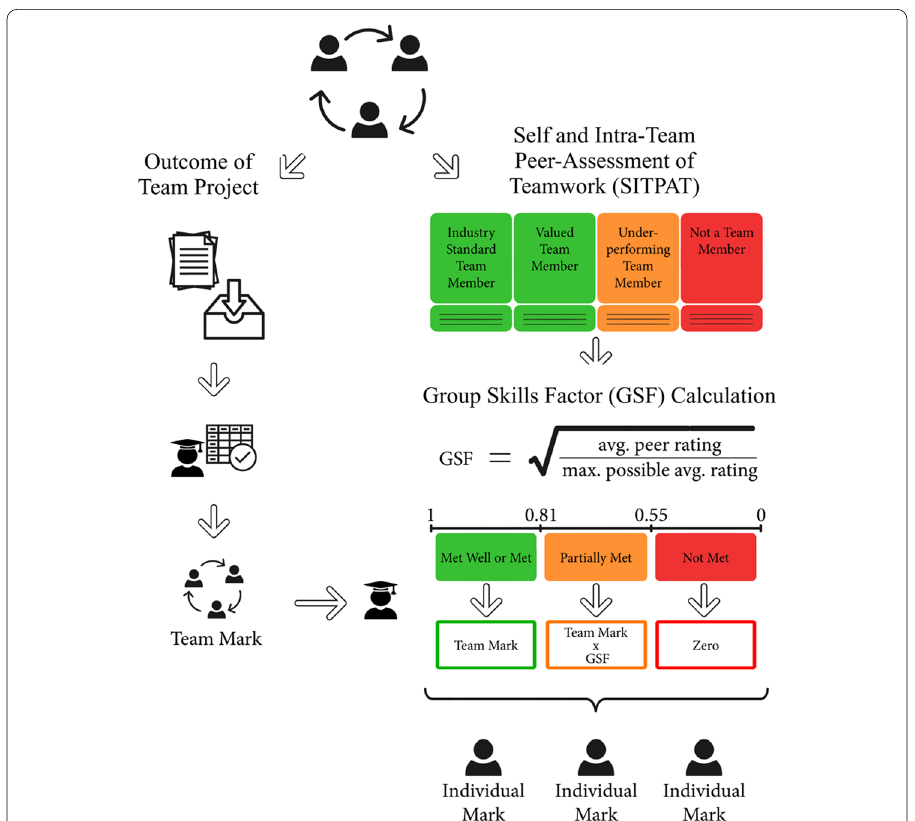
Fig. 1 The pedagogical model of the strategy illustrates the two components: team-based assessment (TBA) and self- and intra-team peer-assessment of teamwork (SITPAT) integrating the group member evaluation (GME) tool, featuring the group skills factor (GSF) calculation that sits inside the group contribution grading (GCG)